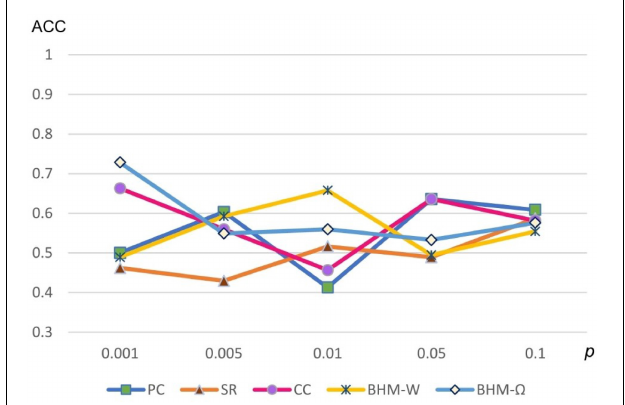
FIGURE 5 | Classification accuracy of ASD identification based on 5 BFNs estimated by PC, CC, SR, and BHM for 5 different p